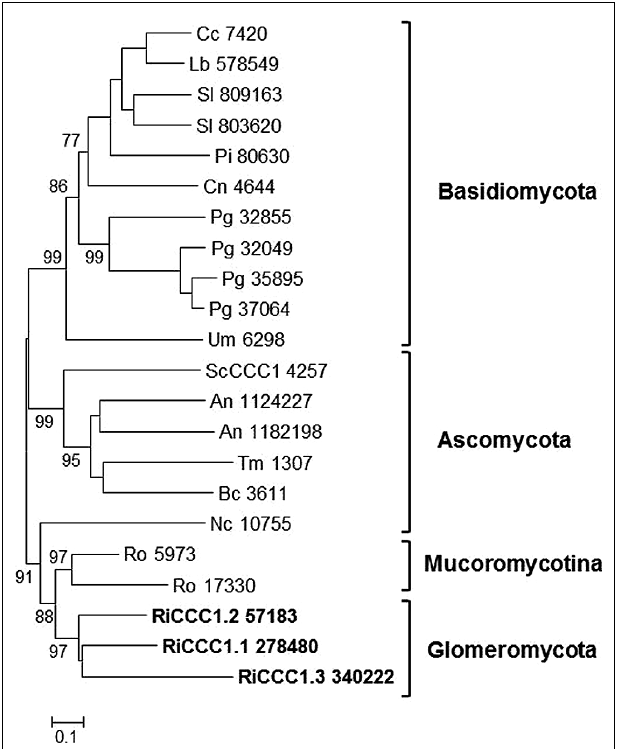
FIGURE 5 | Phylogenetic relationships of the Rhizophagus irregularis vacuolar iron transporters (VIT) with homologous sequences from selected species representative of the major fungal phyla. The Neighbor-Joining tree was created with MEGA 6. Protein JGI identification numbers are indicated. R. irregularis genes are shown in bold. Organisms: An, Aspergillus niger ; Bc, Botrytis cinerea ; Cc, Coprinopsis cinerea ; Cn, Cryptococcus neoformans ; Lb, Laccaria bicolor ; Nc, Neurospora crassa ; Pi, Piriformospora indica ; Pg, Puccinia graminis ; Sc, Saccharomyces cerevisiae ; Sl, Suillus luteus ;Tb, Tuber melanosporum; Ri, Rhizophagus irregularis ; Ro, Rhizopus oryzae ; Um, Ustilago maydis . Bootstrap values above 70 and supporting a node used to define a cluster are